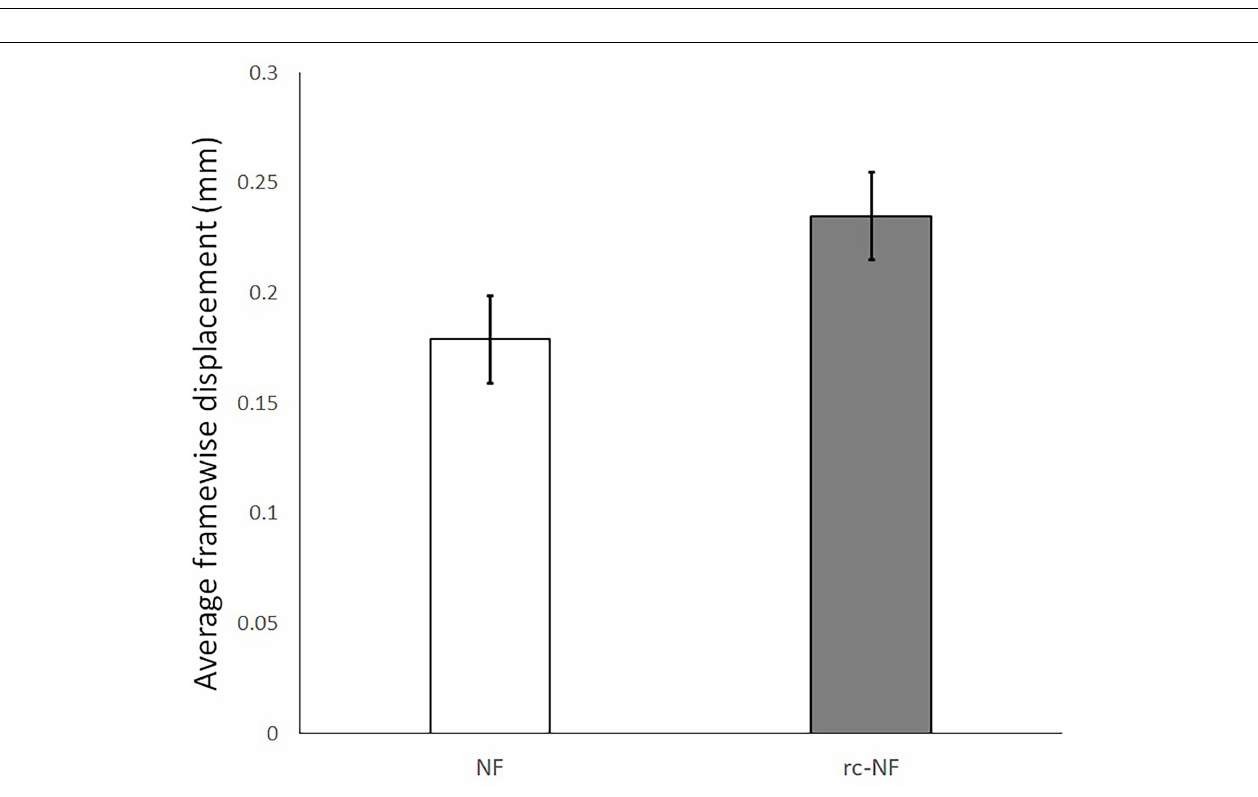
FIGURE 13 | Average framewise displacement with 95% confidence interval in the NF and the rc-NF groups. Head motion seems to be rather lower than in previous fMRI studies on VEs or even non-motor tasks (Mathiak and Weber, 2006; Osterbauer et al., 2006).